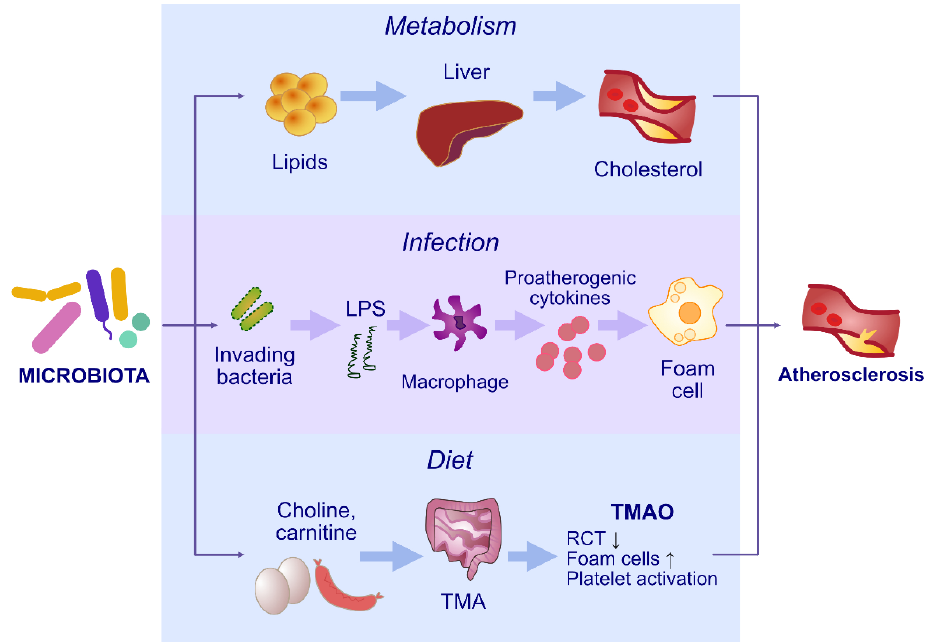
Figure 2. The involvement of oral microbiome dysbiosis in the development of atherosclerosis. LPS — lipopolysaccharide, TMAO — trimethylamine N-oxide, TMA — trimethylamine, RCT — reverse cholesterol transport.